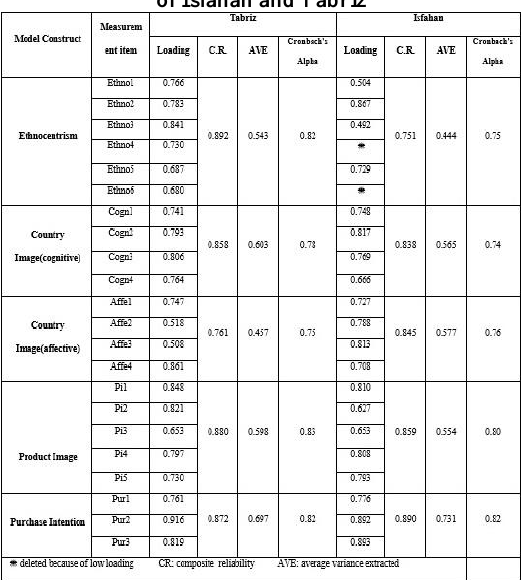
Table 2: Results of Measurement Model for the cities of Isfahan and Tabriz